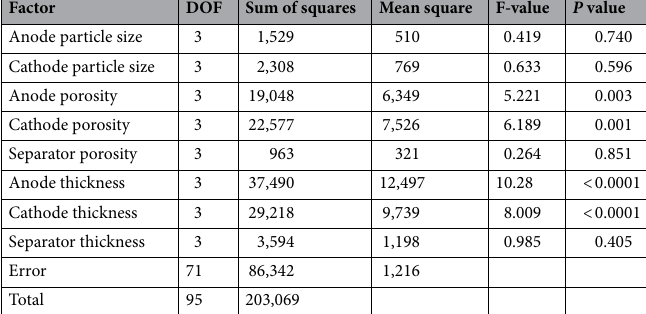
Table 4. ANOVA results of specific energy